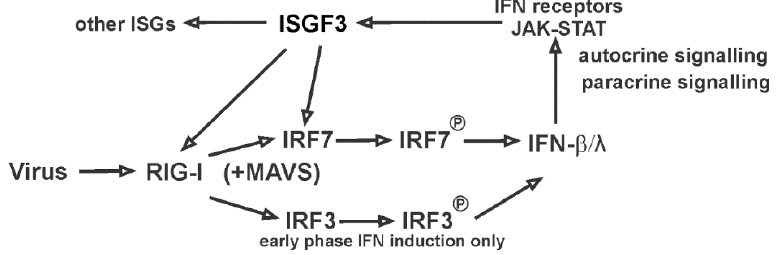
Figure 6. Proposed model of the RIG-I / IRF7 / IFN positive-feedback amplification loop in human lung airway epithelial cells.